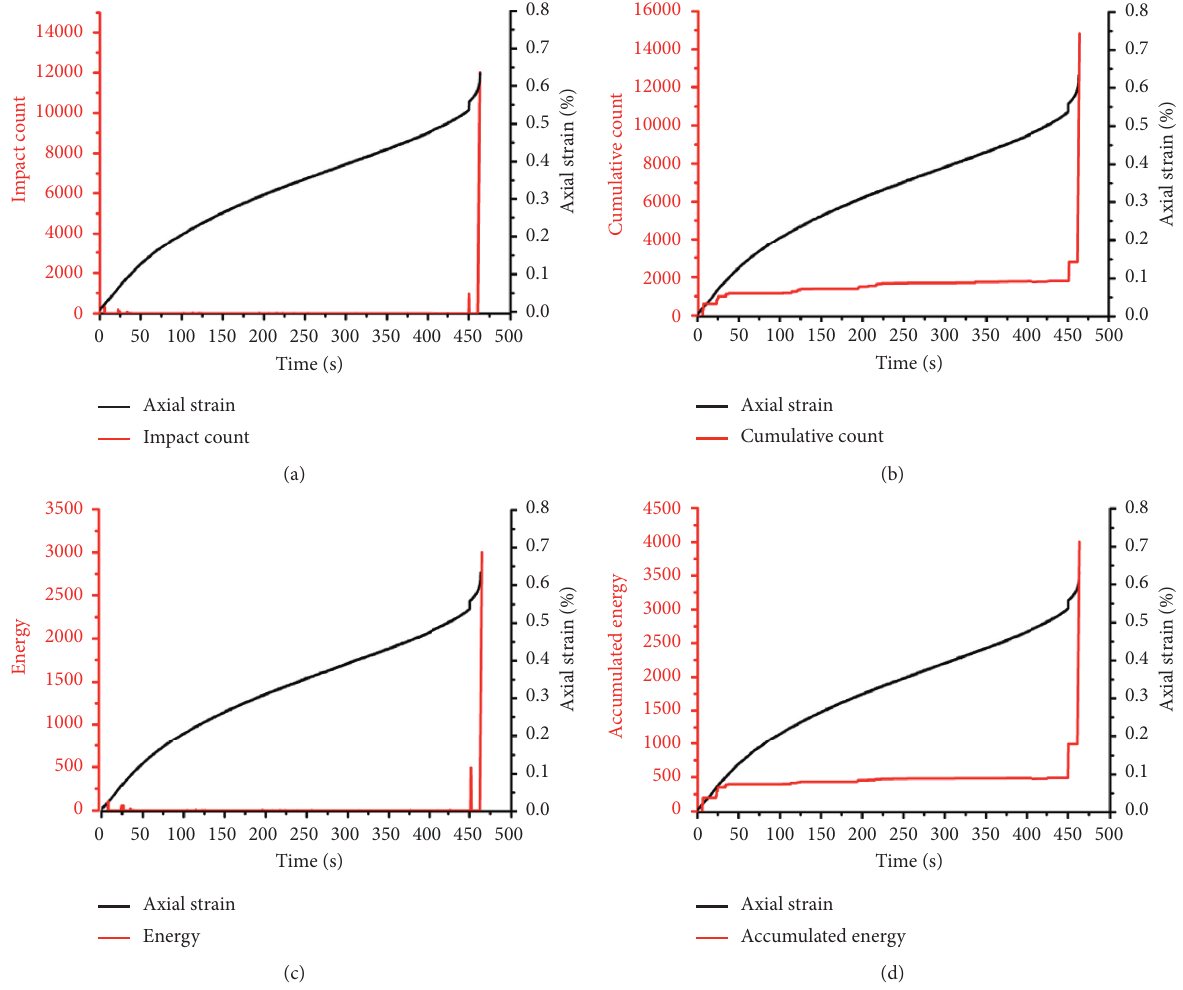
Figure 8: Deformation and acoustic emission characteristics of C-40-1 sample. (a) The curves of ringing count and axial strain of C-40-1 sample with time. (b) The curves of cumulative ringing count and axial strain of C-40-1 sample with time. (c) The curves of energy and axial strain of C-40-1 sample with time. (d) The curves of cumulative energy and axial strain of C-40-1 sample with the curve gradient increases gradually, and the change in cumulative strain caused by stress decreases gradually.